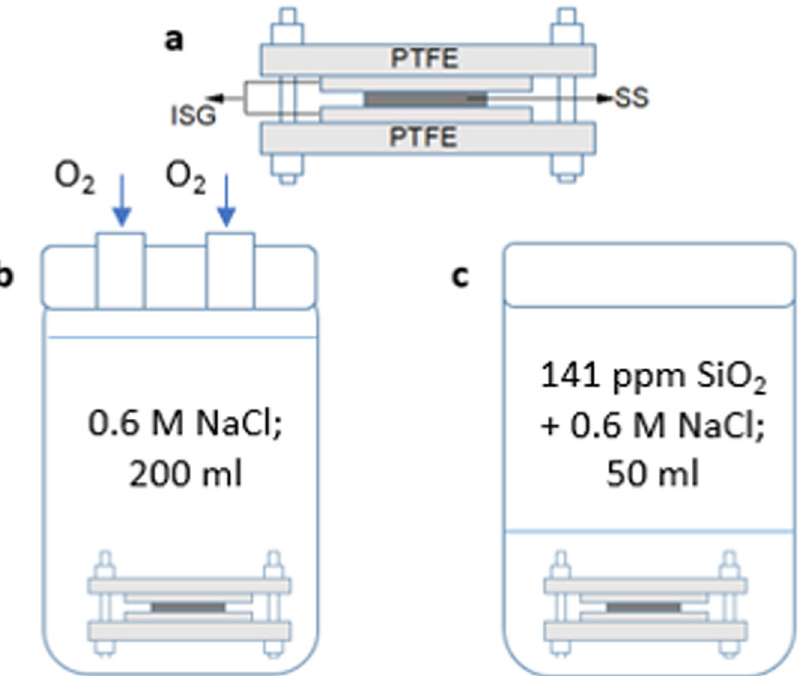
Fig. 11 A schematic illustration of the crevice corrosion experiment setup used in this study. a A SS coupon is sandwiched between two ISG coupons. PTFE plates are placed on the ISG coupons and intimate contact is established with PTFE nuts and bolts. This assembly of samples is then placed in PFA jars. b An illustration of the jar used for 0.6 M NaCl solution. c An illustration of the jar used for silica saturated 0.6 M NaCl. npj Materials Degradation (2022) 50 Published in partnership with CSCP and